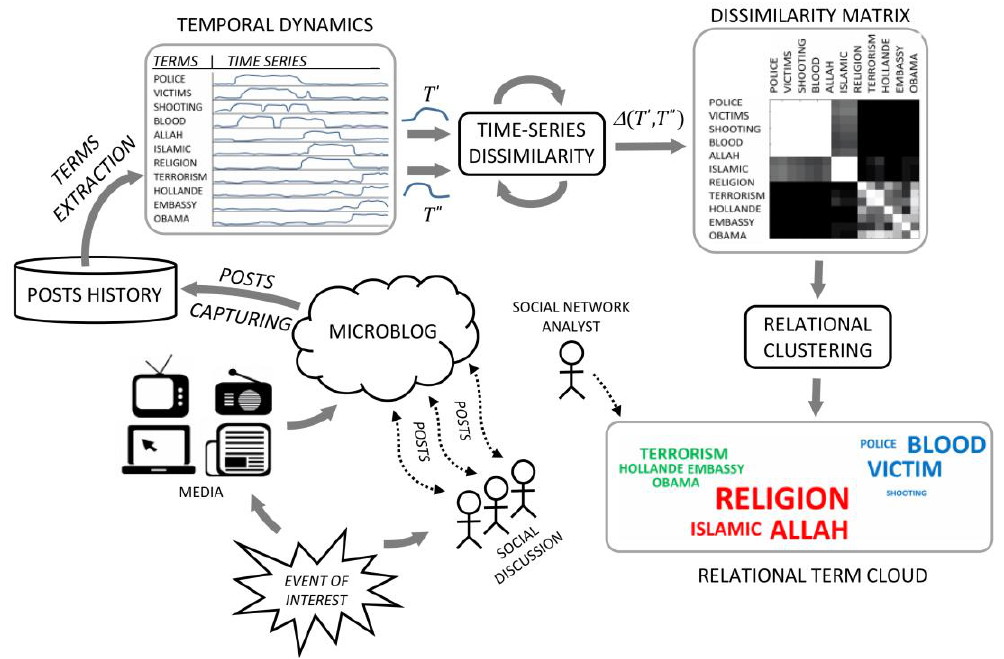
Figure 2. Overview of the proposed approach.